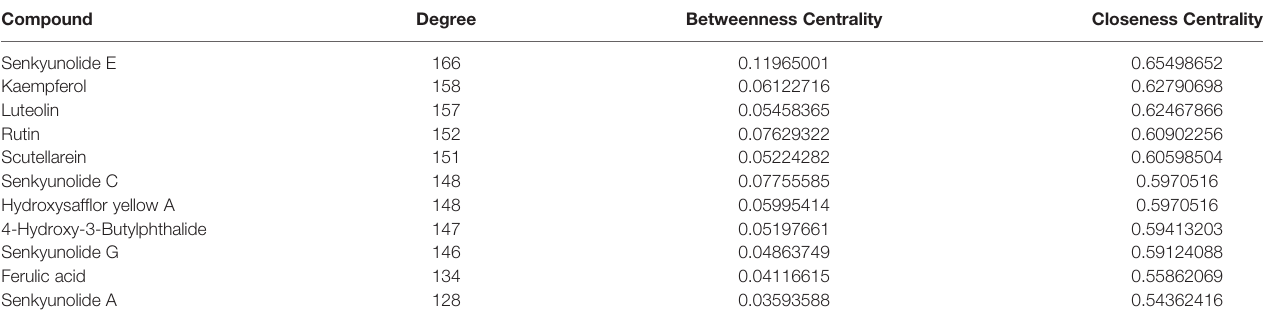
TABLE 3 | Basic information of hub compounds of Tao-Hong-Si-Wu Decoction in the treatment of breast cancer.